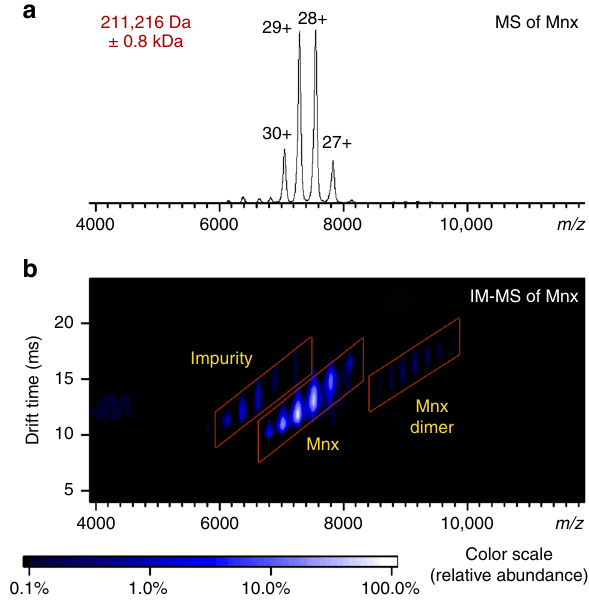
Fig. 1 Native MS of Mnx complex. a Mass spectrum and b ion mobility – mass spectrum of the intact Mnx complex. The major species correspond to the Mnx complex with a molecular weight of 211 kDa. The impurity is a host cell protein complex that carried over during puri fi cation (Supplementary Note 2). Identical data are displayed in a , b , with b showing the extra dimension of separation in the vertical axis from the drift time recorded in ion mobility. The IM – MS spectrum has the m/z on the horizontal axis from the mass spectrometry measurement and the drift time measurement from the ion mobility separation in the vertical axis. The ions were separated based on their shape-to-charge ratio in ion mobility and arrived at the mass analyzer for m/z detection at discrete drift times, generating the two-dimensional spectra. The color of the spots indicates the relative abundance as shown by the scale at the bottom. The full peak width at half maximum in a is about 55 m/z , or about 1.6 kDa ( ± 0.8 kDa) in uncertainty in mass